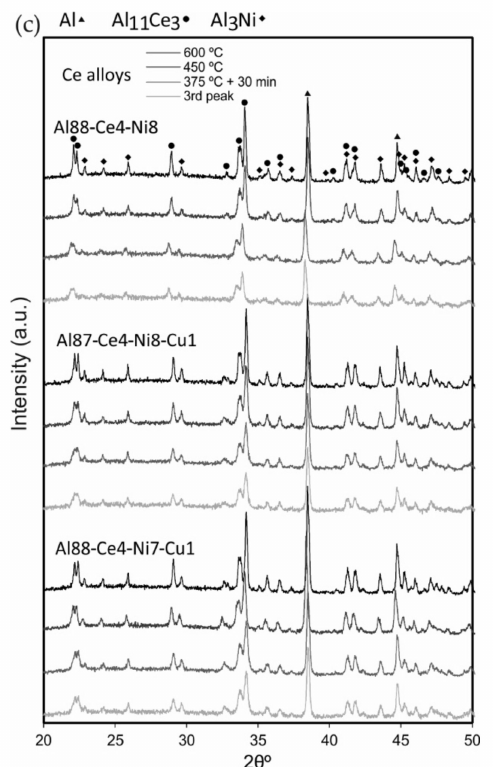
Figure 6. XRD patterns of ( a ) Y, ( b ) Sm, and ( c ) Ce-containing alloys after heat treating to the peak of the third DSC reaction (355–365 ◦ C) to 375 ◦ C (end of the reaction) held for 30 min, to 450 ◦ C and to 600 ◦